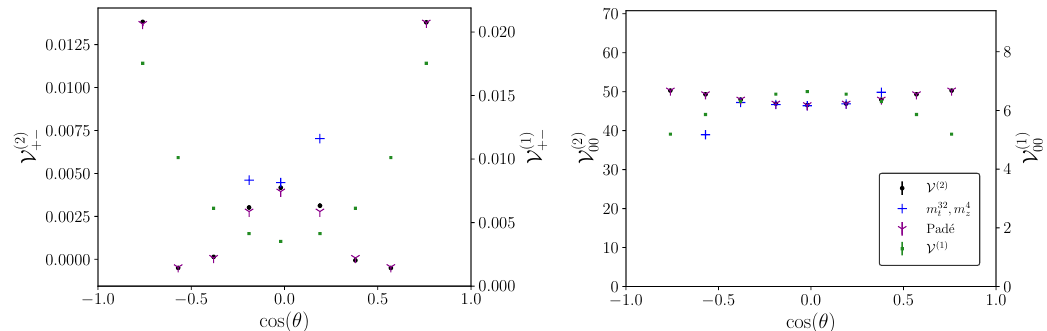
Figure 16. The cos( θ ) dependence of 1-loop and 2-loop interferences for polarised ZZ production √ in gluon fusion at s/m t = 4 . 703 . The small top-quark mass expansion (to order m 32 improved expansion [36] are shown for comparison. Here we reproduce the top left and bottom right panels of figure 12 using Catani’s original subtraction scheme